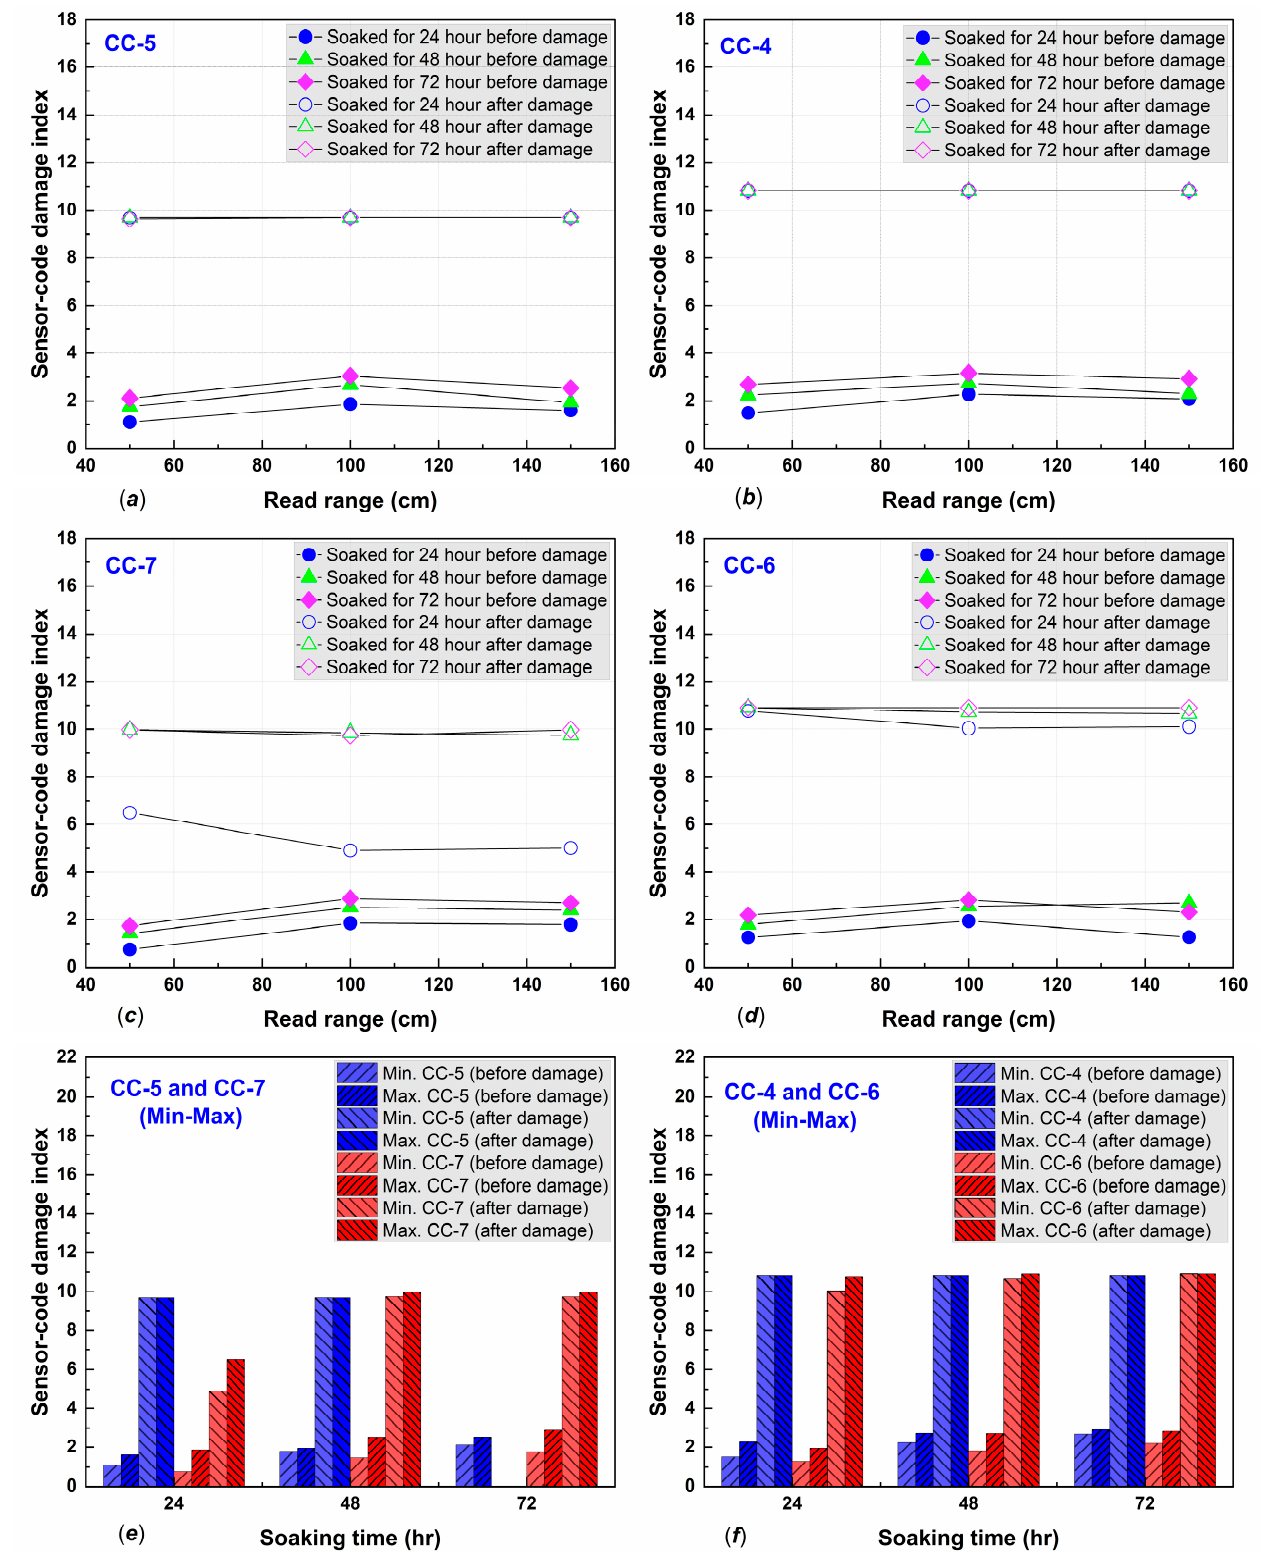
Figure 9. Damage indices of ( a ) CC-5, ( b ) CC-4 ( c ) CC-7, ( d ) CC-6, ( e ) minimum and a maximum of CC-5 and CC-7 before–after damage, and ( f ) minimum and a maximum of CC-4 and CC-6 before–after damage.